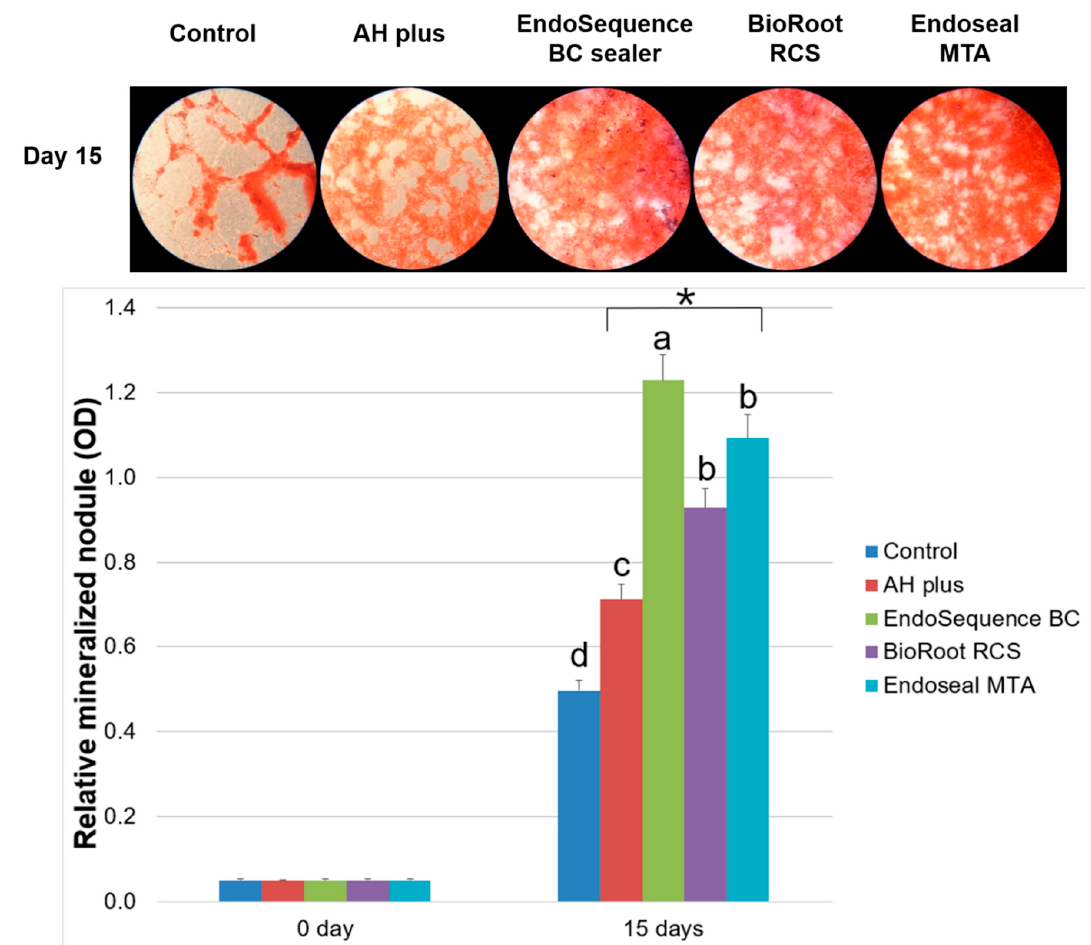
Figure 6. Relative mineralized nodule formation rate based on Alizarin red staining assay. Asterisk indicates a statistically significant difference between the control group and experimental groups. Different superscript letters indicate statistically significant differences.